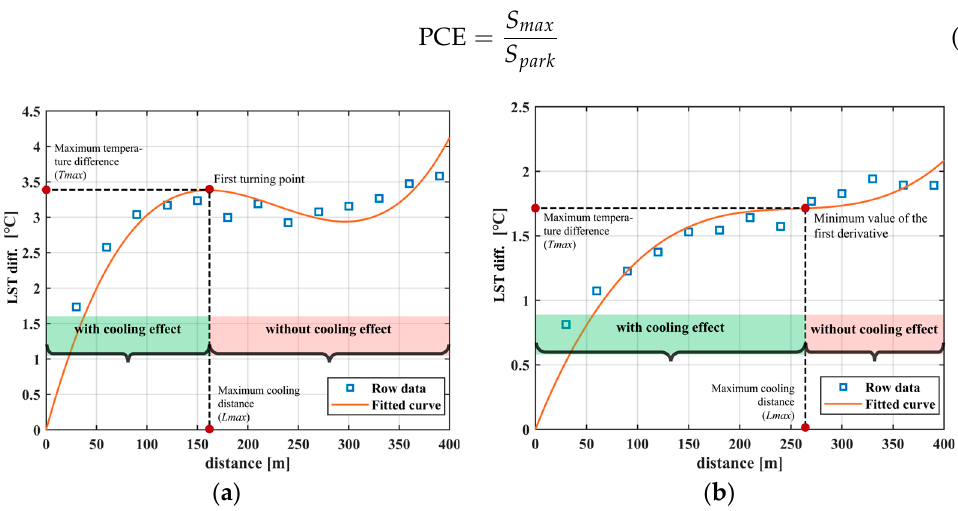
Figure 2. Illustration of two types of LST change curves of park cooling process: ( a ) LST change curves of the park cooling process with a real first turning point; ( b ) LST change curves of the park cooling process without a real first turning point.